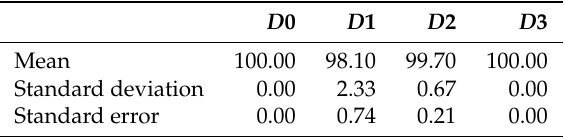
Table 11. Repeatability of the SHM strategy (10 times): scenario 2 and majority voting approach. D 0: healthy state of the structure; D 1, D 2, and D 3: added masses at the positions indicated in Figure